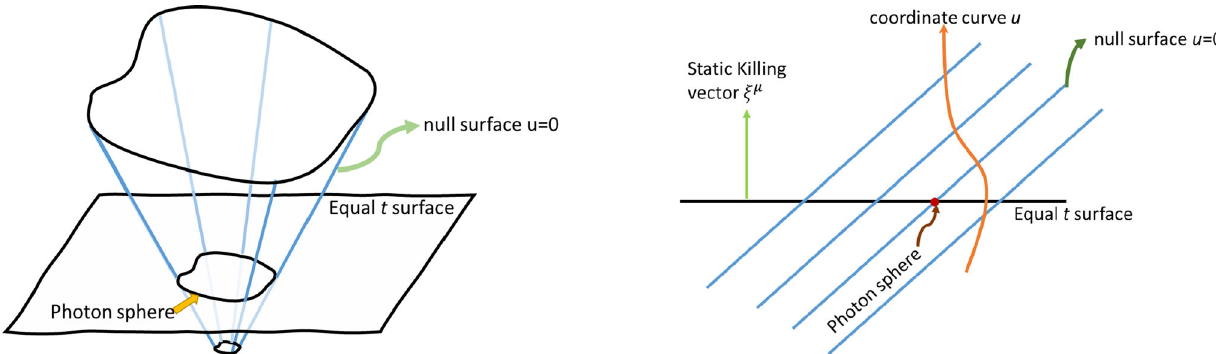
Other null sheets are obtained by using translation generated by static Killing vector ξ μ . The u -coordinate is free and we can choose arbitrary timelike curve which passes through these null